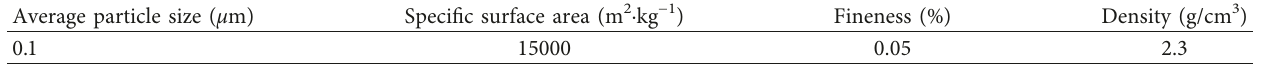
Table 1: Silica fume performance